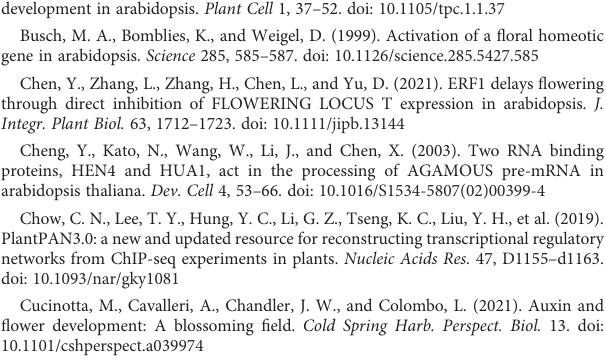
SUPPLEMENTARY FIGURE 1 The phenotype of XY1 and YY85 plants in cold induced early fl owering in tobacco. (A) The time to bud stage of XY1 and YY85 under cold treatment. (B) The number of leaves in XY1 and YY85 under cold treatment. 5 plants of each treatment were collected for data analysis, and the experiment was repeated twice. SUPPLEMENTARY FIGURE 2 Microarray expression pro fi le analysis of tobaccos responding to chill condition in different species. (A) PCA plot of microarrays (X12 means XY1 under 12°C treatment; X28 means XY1 under 28°C treatment; Y12 means YY85 under 12°C treatment;Y28 means YY85 under 28°C treatment). (B) Heat map and cluster of microarrays. The color bar represents gene expression level (FPKM). Three independent biological replicates were used in this analysis. SUPPLEMENTARY FIGURE 3 qRT-PCR of NtFLC gene in different species responding to cold treatment. The seedlings of XY1 and YY85 plants were treated with cold stress (12°C for 10 days, 16h light/8h dark), and then all plants were moved into the greenhouse (28°C, 16h light/8h dark). The samples were collected in 0d, 4d, 7d, 10d, 17d and 24d after cold treatment for qRT-PCR (# means cold treatment). Data are shown as the mean ± SD from three independent experiment replicates. Signi fi cant changes measured by Student ’ s t test (* means p < 0.05 and ** means p < 0.01). SUPPLEMENTARY FIGURE 4 Top 20 GO and KEGG enrichment of DEGs in XY1 and YY85 under cold treatment. SUPPLEMENTARY FIGURE 5 qRT-PCR of NtFLC and NtLFY genes in responding to BR treatment. The seedlingsof HDplants weregrowinthegreenhouse (28°C,16hlight/8hdark). When sixth true leaf appeared, plants were treated with brassinolide, and samples were collected in 0h, 2h, 4h, 6h and 8h after cold treatment for qRT- PCR. Data are shown as the mean ± SD from three independent experiment replicates. Signi fi cant changes measured by Student ’ s t test (* means p < 0.05 and ** means p < 0.01). SUPPLEMENTARY FIGURE 6 qRT-PCR of NtBRI1 in responding to BR treatment and cold stress. For BR treatment, the seedlings of HD plants were grow in the greenhouse (28°C, 16h light/8h dark). When sixth true leaf appeared, plants were treated with brassinolide, and samples were collected in 0h, 2h, 4h, 6h and 8h after cold treatment for qRT-PCR. For cold stress treatment, the seedlings of HD plants were treated with cold stress (12°C for 10 days, 16h light/8h dark), and then all plants were moved into the greenhouse (28°C, 16h light/8h dark). The samples were collected in 1d, 4d, 7d, 10d, 17d and 24d after cold treatment for qRT-PCR (# means cold treatment). Data are shown as the mean ± SD from three independent experiment replicates. Signi fi cant changes measured by Student ’ s t test (* means p < 0.05 and ** means p <